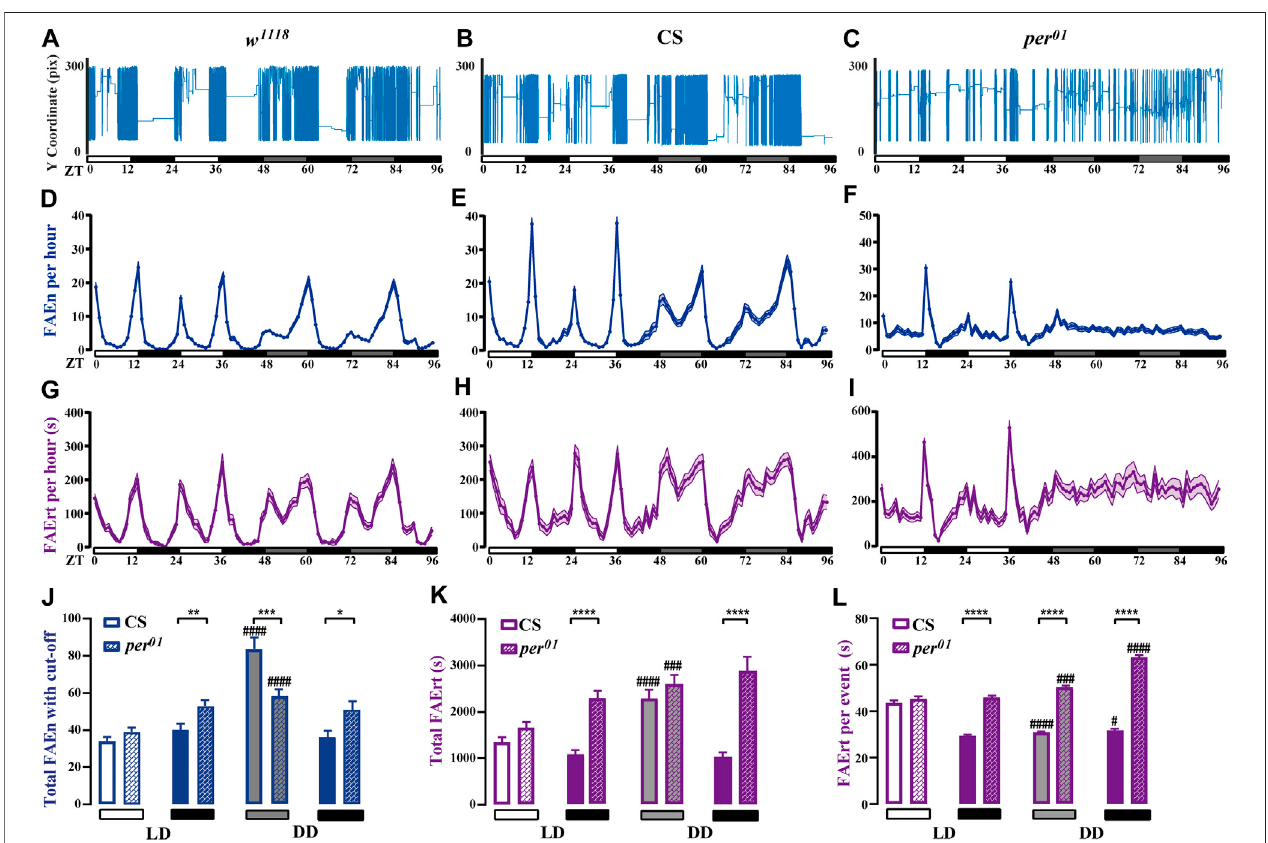
FIGURE6| FeedingrhythmanalysisunderLDandDDconditionsofwild-typeand per 01 mutant fl ies (A – C) Themovementtrackofarepresentativemale fl yofwild- type w 1118 and CS, as well as per 01 mutant (D – I) dFRAME analysis of FAEn ( D – F , with no cut-off) and FAErt (G – I) for three types of fl ies under continuous LD and DD cycles for 4 days (J – L) The day time and night time of total FAEn ( J , with 7-s cut-off), total FAErt (K) , and FAErt/n (L) under LD and DD conditions. Symbols: #, ##, ###, and #### indicate signi fi cance when comparing DD conditions to LD conditions of corresponding genotype and corresponding day or night time. w 1118 , n (cid:1) 88; CS, n (cid:1) 66; and per 01 , n (cid:1) 72. Data are shown as mean ± SEM. # p < 0.05; ** or ## p < 0.01; ### p < 0.001; **** or #### p < 0.0001. No label means no signi fi cant